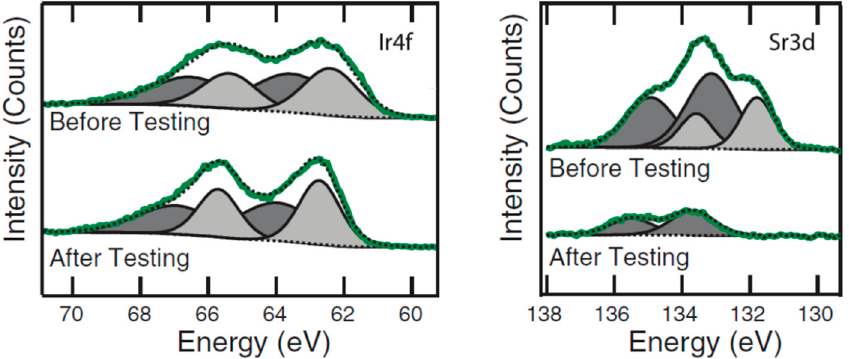
Figure 2. XPS spectra of 100 nm SrIrO 3 film (before and after 30 min of OER), showing the attenuation of the Sr 3d peak, due to leaching. Reproduced from [16], with permission from the American Association for the Advancement of Science, copyright 2016.